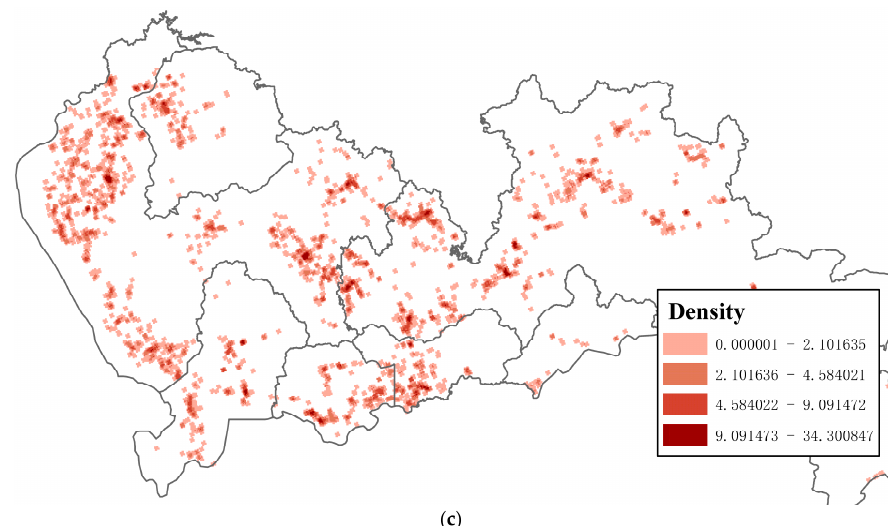
Figure 6. The kernel density surfaces (300-m bandwidth) for individual features: ( a ) bank; ( b ) retail store; and ( c ) hotel.